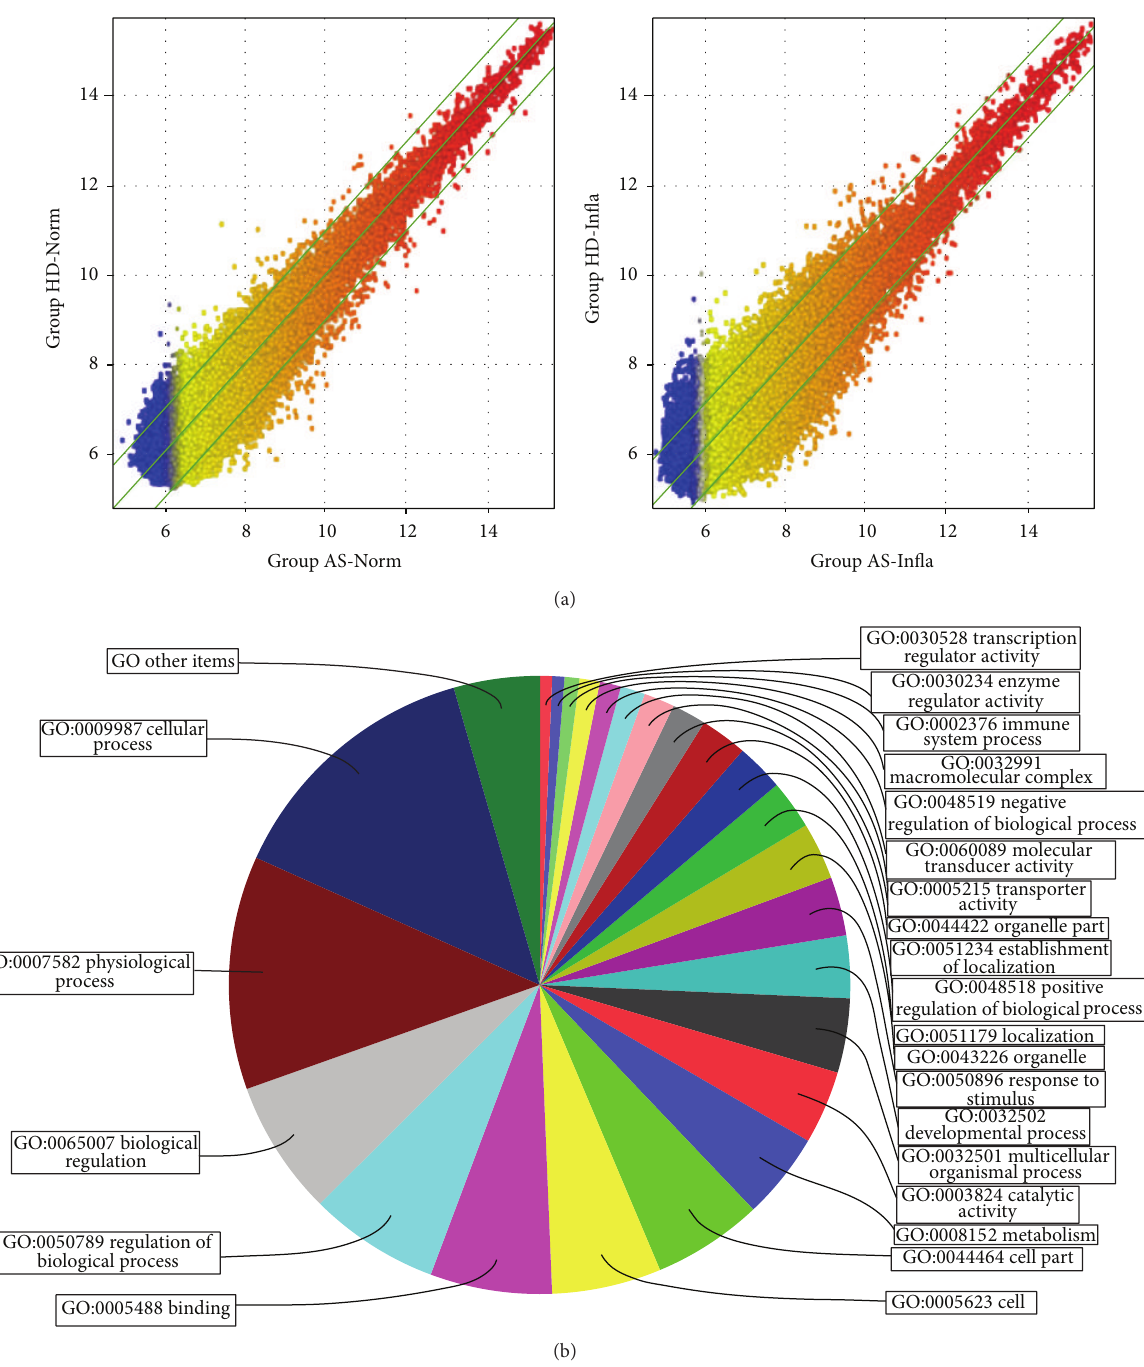
Figure 2: Whole genomic expression analysis of MSCs in AS patients. (a) shows the scatter plot of differentially expressed genes of MSCs from both healthy donors and AS patients, respectively, in both normal and inflammatory culture environment. The values of 𝑥 and 𝑦 axes in the scatter plot are the normalized signal values of each sample (log2 scaled). The green lines are fold change lines (the default fold change value given is 2.0). Genes above the top green line and below the bottom green line indicated more than 2.0-fold change of genes between two compared arrays. (b) shows the pie chart of gene ontology (GO) analysis of results of the differentially expressed genes of MSCs between group AS-Infla and group HD-Infla. Among the 1590 genes, 892 (56.10%) participated in biological process, 461 (28.99%) played a role in molecular function, and 237 (14.91%) associated with cellular